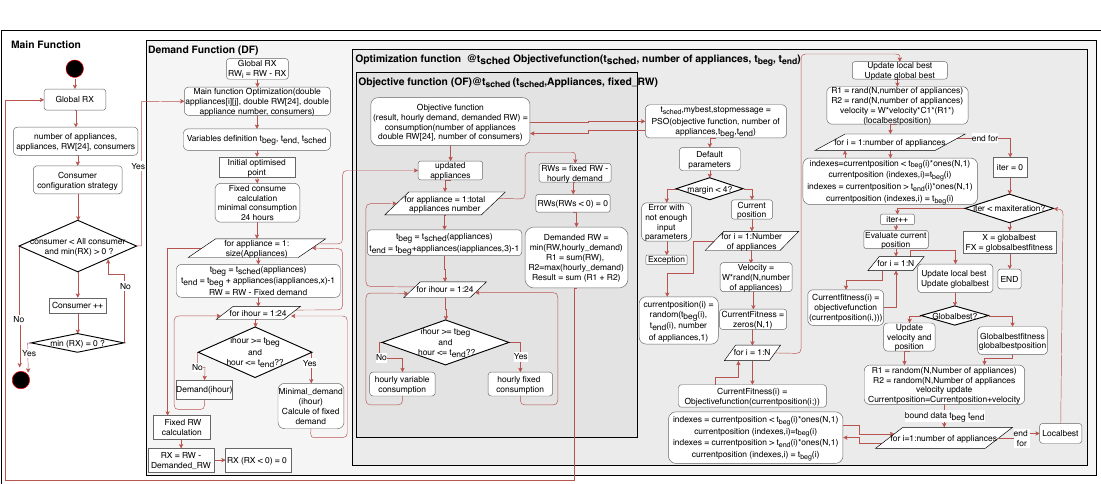
Figure A1. Activity graph describing the implementation of the aggregation and optimization